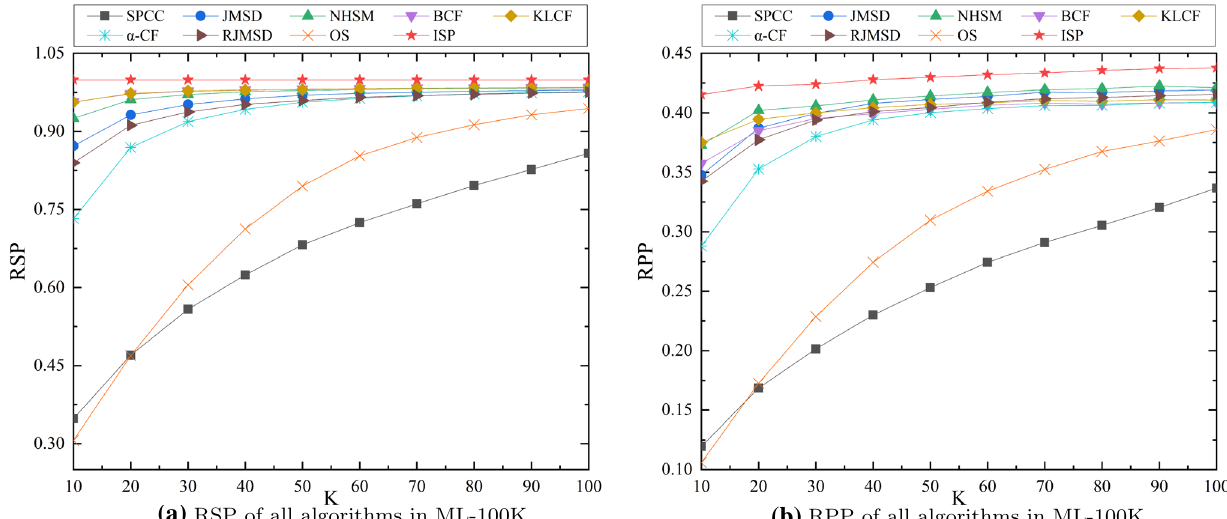
(a) RSP of all algorithms in ML-100K. Fig. 7 RSP and RPP values of all algorithms in